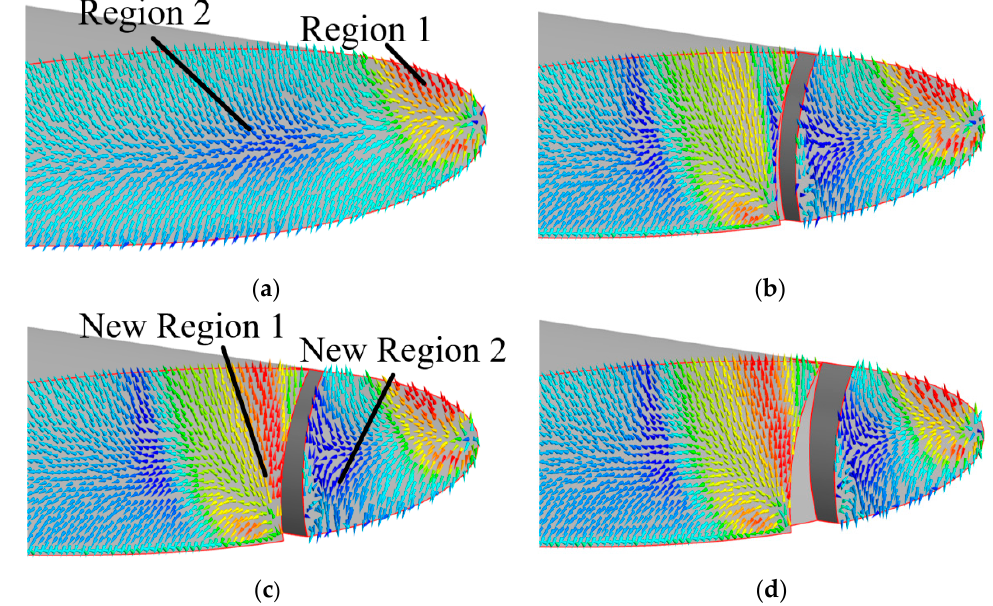
Figure 12. Velocity vector of the foil tip. ( a ) Origin Case, ( b ) Case A, ( c ) Case B, ( d ) Case C.